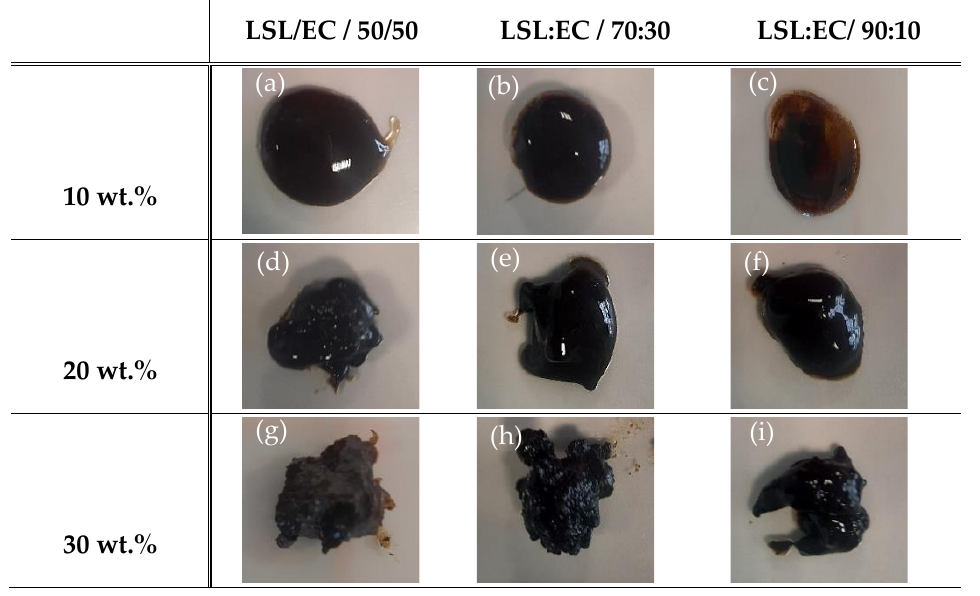
Figure 3. Physical appearance of LSL/EC nanostructures of different LSL:EC ratios (50:50, 70:30, 90:10) dispersed in castor oil at several concentrations (10, 20, and 30 wt.%).